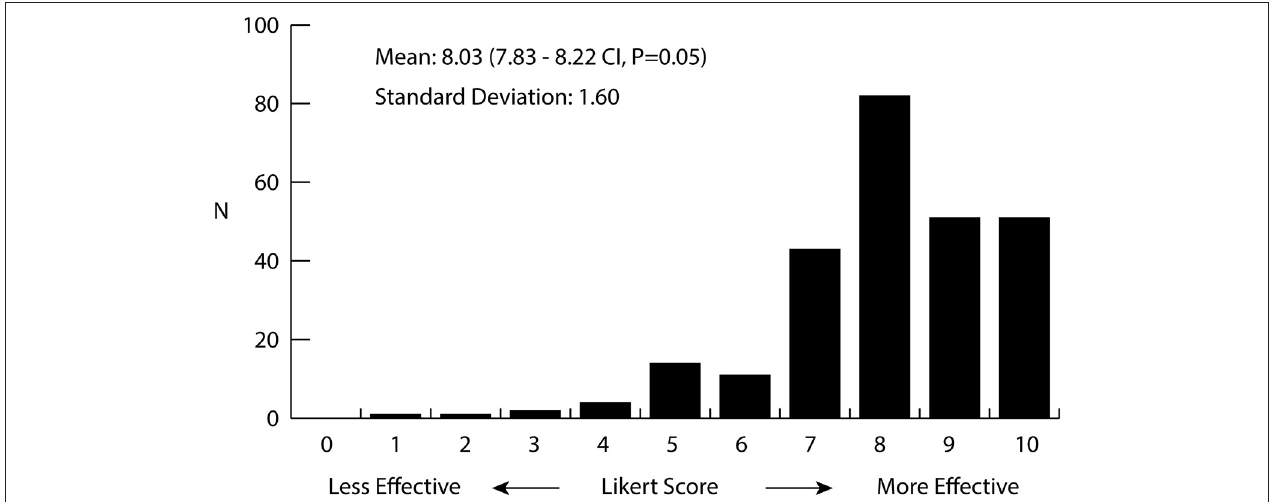
FIGURE 1 | Histogram of the perceived effectiveness of cannabis for the treatment of anxiety as rated by medical cannabis patients. Patients ( n = 260) were asked to rate the effectiveness of cannabis for the treatment of anxiety on a Likert scale from 0 to 10, 0 being not effective at all and 10 being extremely effective. Average value was 8.03 (7.83–8.22 CI, p = 0.05) with a standard deviation of 1.60.